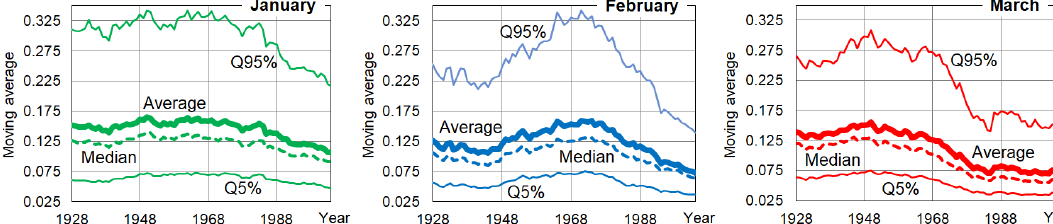
Figure 10. Median, average and empirical quantiles for the non-exceedance probabilities of 5% (Q5%) and 95% (Q95%) of the dimensionless moving averages of the rainfall in January, February and March, from 1913/1914 on, at the 532 rain gauges (running length of 30 years). Each moving was made dimensionless by reference to the average of the mean annual rainfalls and assigned to the first civil year of the 16th hydrological year of the corresponding 30-year